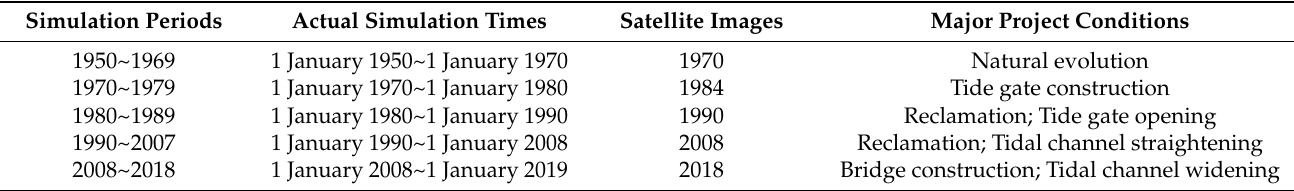
Figure 5. Initial bathymetric map of QL and adjacent rivers of 1950. Table 2. Reference satellite images and human intervention projects for geomorphological simulation during 5 phases between 1950 and 2018.